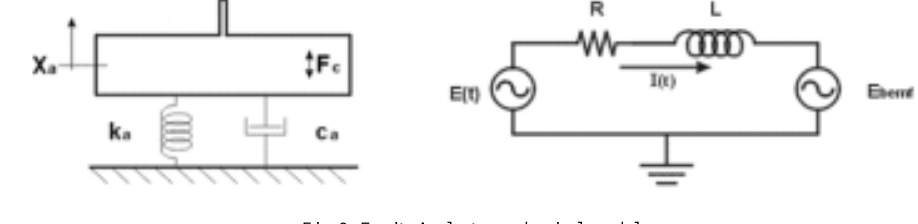
Fig. 3. Exciter’s electromechanical model.